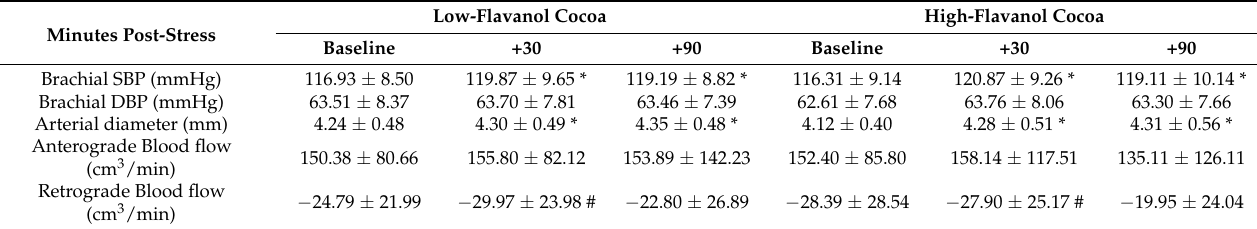
Table 4. Endothelial function following acute mental stress (Mean ±